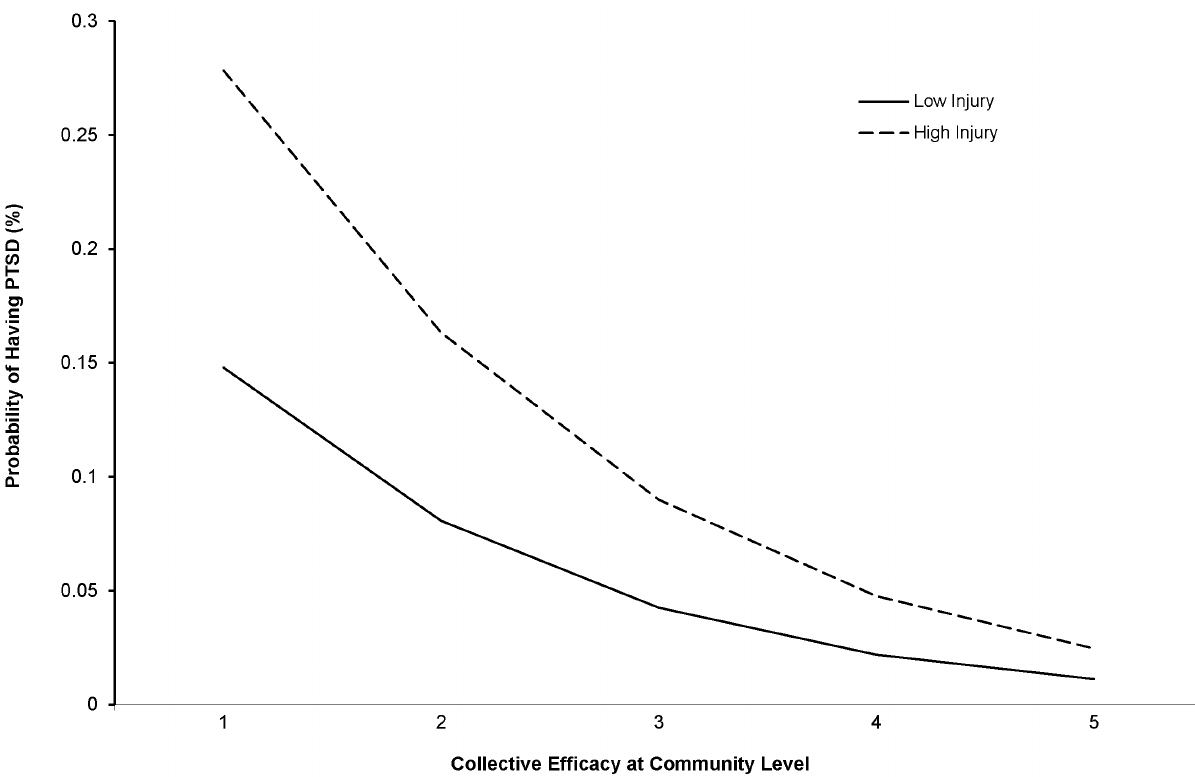
Figure 1. Changes in probability of having PTSD over two injury/damage groups and five community-level efficacy levels.